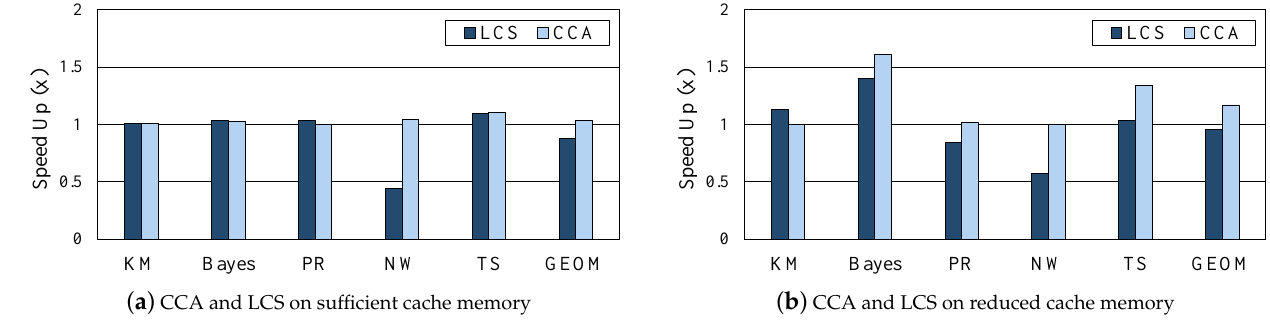
Figure 10. Comparison between the proposed CCA and other cache memory management